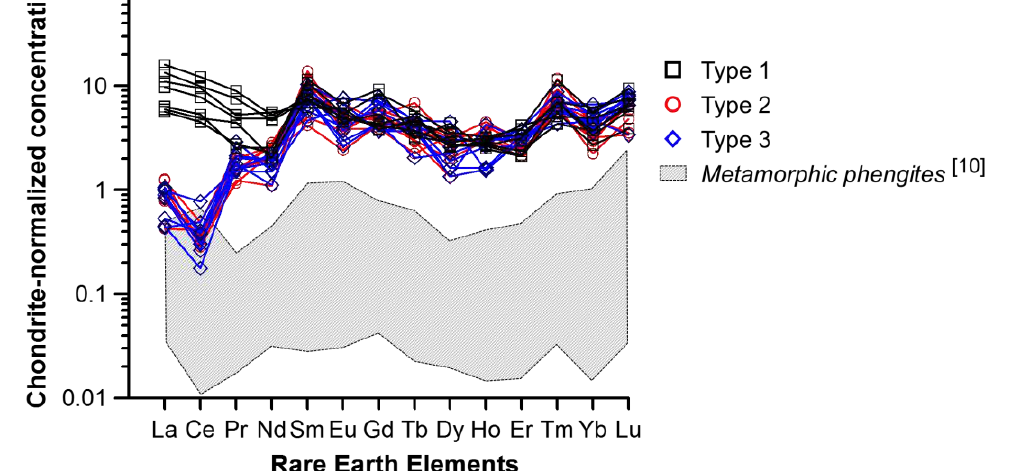
Figure 9. The chondrite-normalized rare earth elements (REEs) patterns of the phengites from the Haengmae Formation. The shadow area indicates the range of REE patterns for the metamorphic phengites [10].